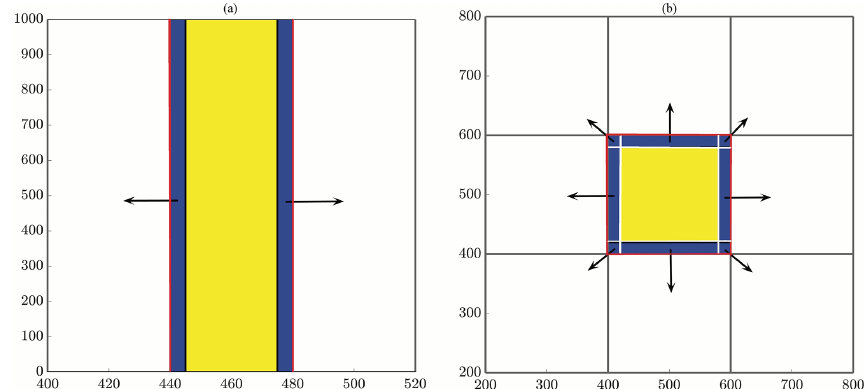
Figure 4. All particles within a buffer width of ψ from the boundary of a subdomain (blue) are sent to the left and to the right for reaction in the slices method (a) , whereas they are sent to eight neighboring regions in the checkerboard method (b) . Note that the red lines depict subdomain boundaries, and the black arrows indicate the outward send of ghost particles to neighbors. Also, note that the tails of the black arrows begin within the blue buffer region. Ghost pad size is exaggerated for demonstration.